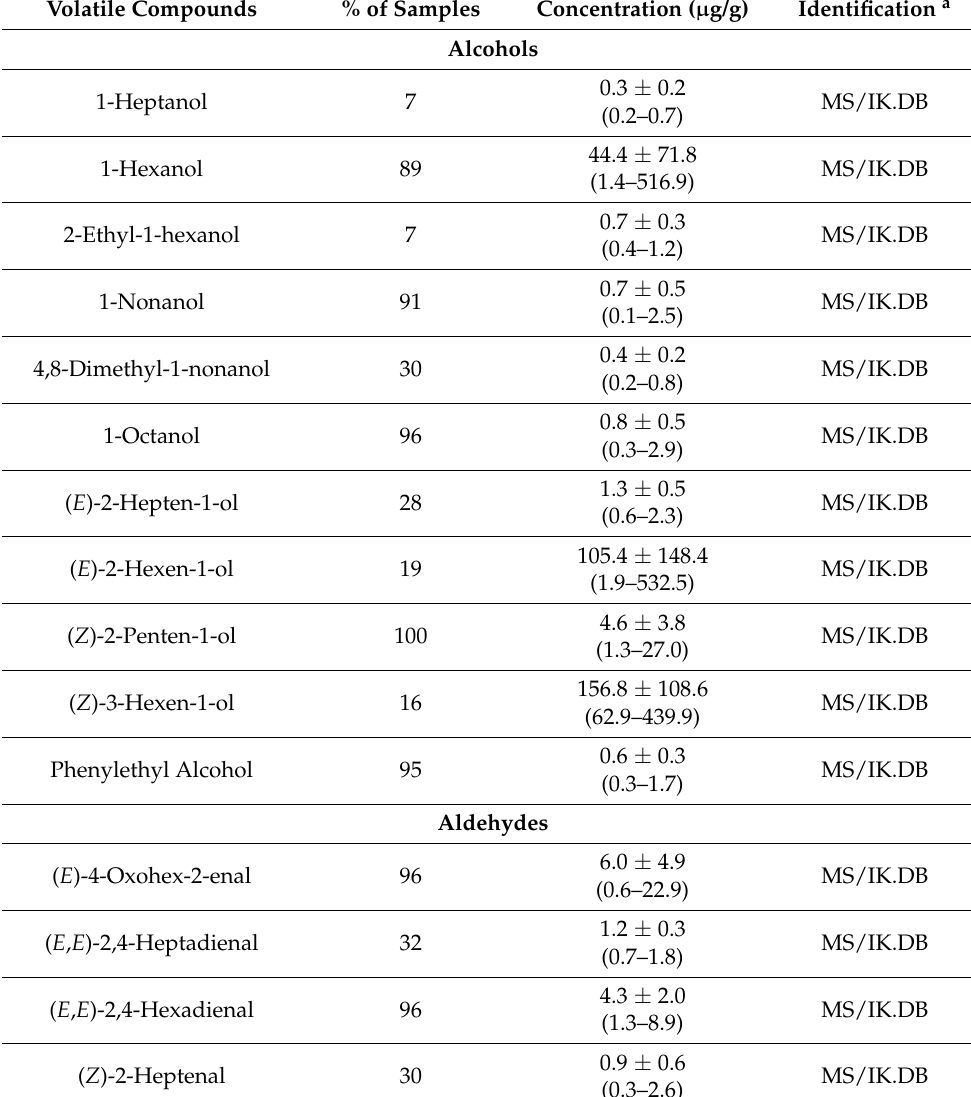
Table 1. Volatile compounds identified in Douro extra virgin olive